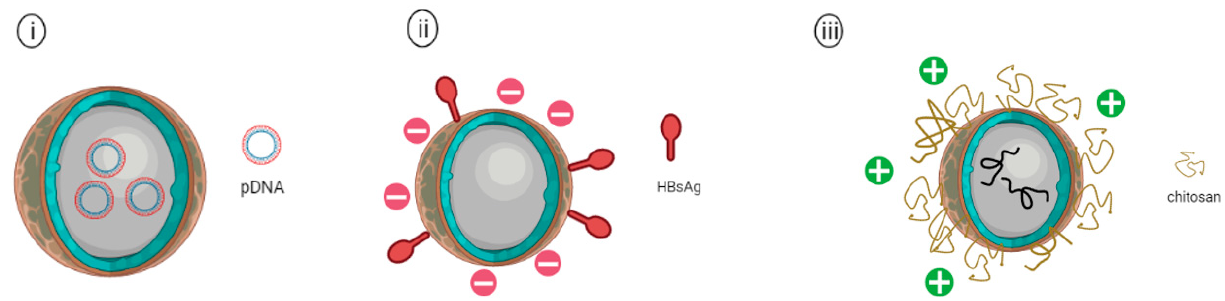
Figure 5. Schematic representation of ( i ) PLGA nanoparticles encapsulating plasmid DNA vaccine, ( ii ) PLGA nanoparticle adsorbed with hepatitis B surface antigen (HBsAg) on the surface of PLGA NP, and ( iii ) Chitosan coated PLGA nanoparticle encapsulating avian influenza antigens.